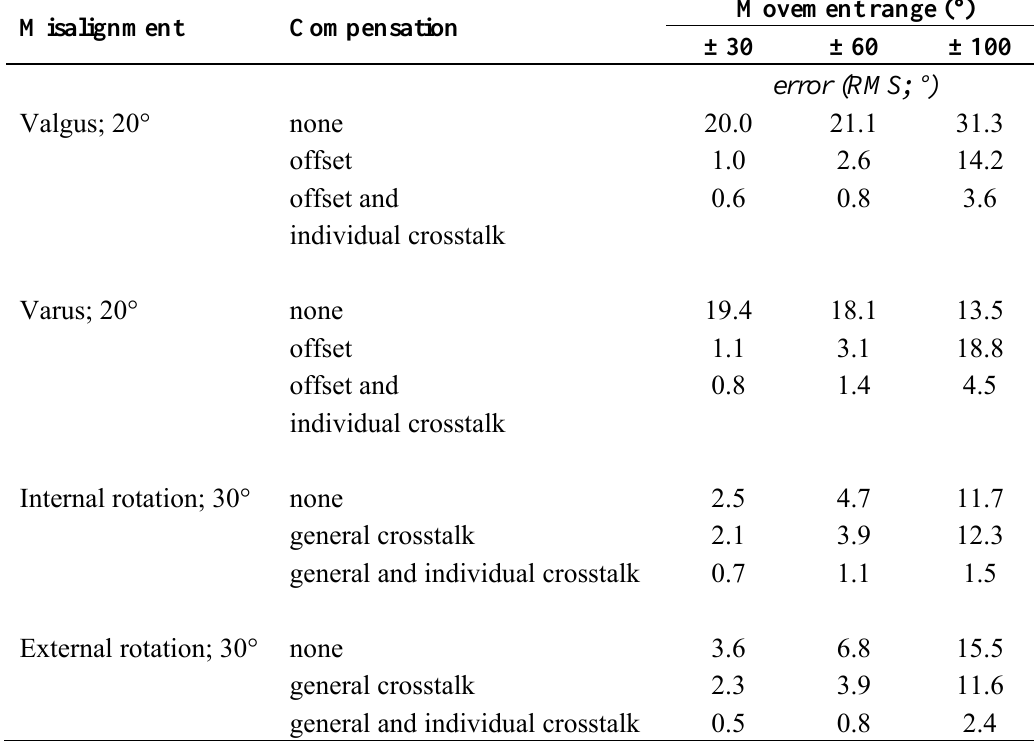
Table 1. Mean error in valgus/varus recordings for one goniometer mounted with valgus/varus and internal/external rotational misalignments of ±20° and ±30° respectively, during pure flexion/extension movements with ±100° amplitude. Root mean square (RMS) errors are shown for ±30°, ±60° and ±100° range of motion. For valgus/varus misalignments, RMS errors are shown for data without any compensation (none), with compensation for valgus/varus offset (offset) and with compensation for offset and individual crosstalk (offset and individual crosstalk). For internal/external rotational misalignments, RMS errors are shown for data without any compensation (none), with compensation for general crosstalk and with compensation for general and individual crosstalk (general and individual